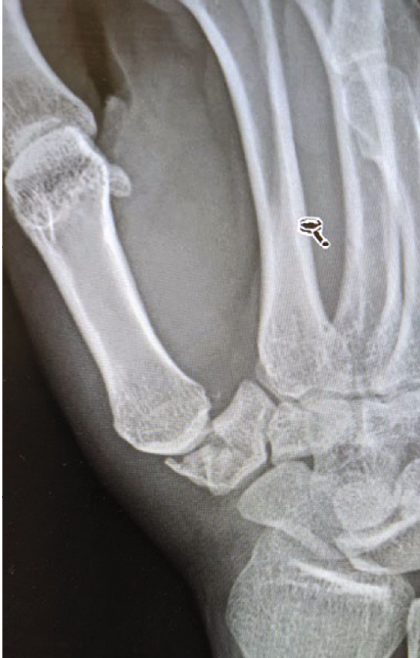
Figure 1: Plan radiograph at presentation demonstrating trapezium fracture with associated carpometacarpal subluxation.